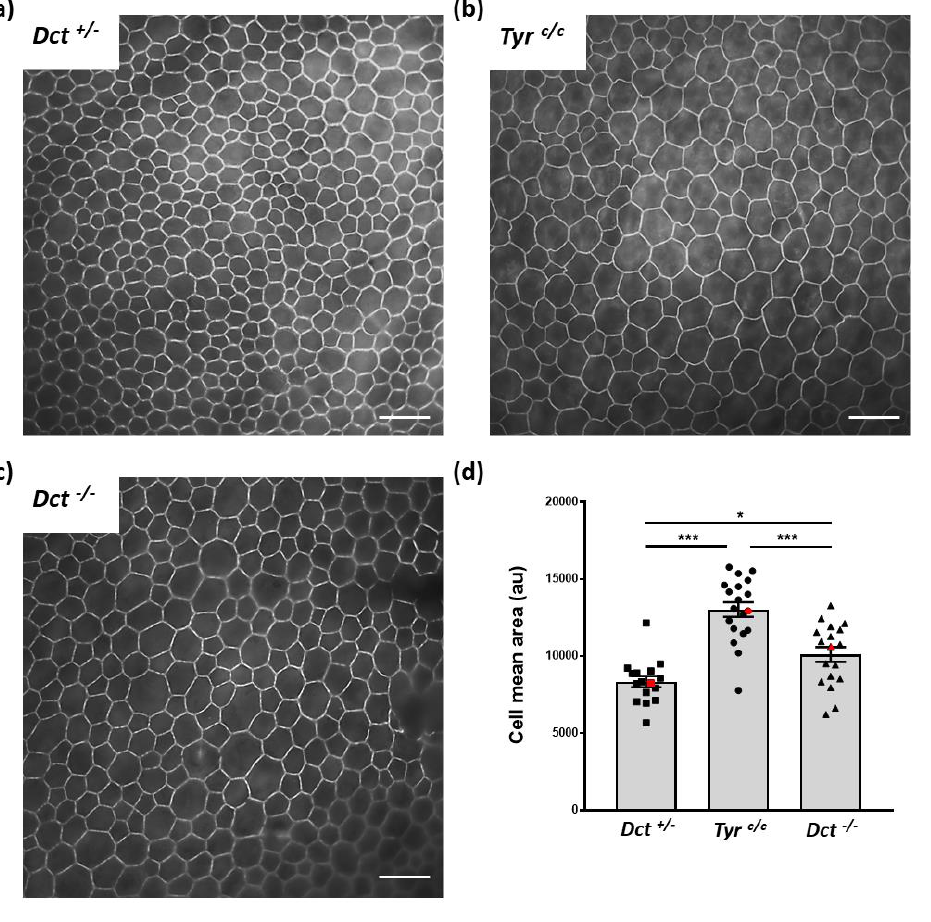
Figure 4. RPE cell size and shape at P0.5. Total RPE flat mounts (for each genotype n = 6; 2 RPEs from 3 mice) were labeled with Alexafluor 488 phalloidin (see whole samples at low magnification, Figure S3), and contiguous images of the whole surface were acquired through a × 40 oil immersion lens for one representative eye per genotype, scale bar: 25 µ m. A representative image for each genotype is shown. ( a ) Dct +/ − used as wild-type littermate control; ( b ) Tyr c/c used as age-matched non-littermate albino control displaying bigger cells than Dct +/ − ; ( c ) Dct − / − also displaying bigger cells than Dct +/ − ; ( d ) the cell size distribution and average were estimated by manually scoring all cells in each contiguous images from both left and right RPEs of one animal per genotype (number of fields: Dct +/ − n = 16, Tyr c/c n = 19, Dct − / − n = 18). The deduced average cell size was plotted for each field. Red symbols correspond to the mean values calculated from selected fields in 4a, 4b, and 4c. The mean ± SEM is indicated by histograms. Significance of differences between groups was determined by one-way ANOVA followed by the Bonferroni post-hoc multiple comparison test, * p < 0.05; *** p <